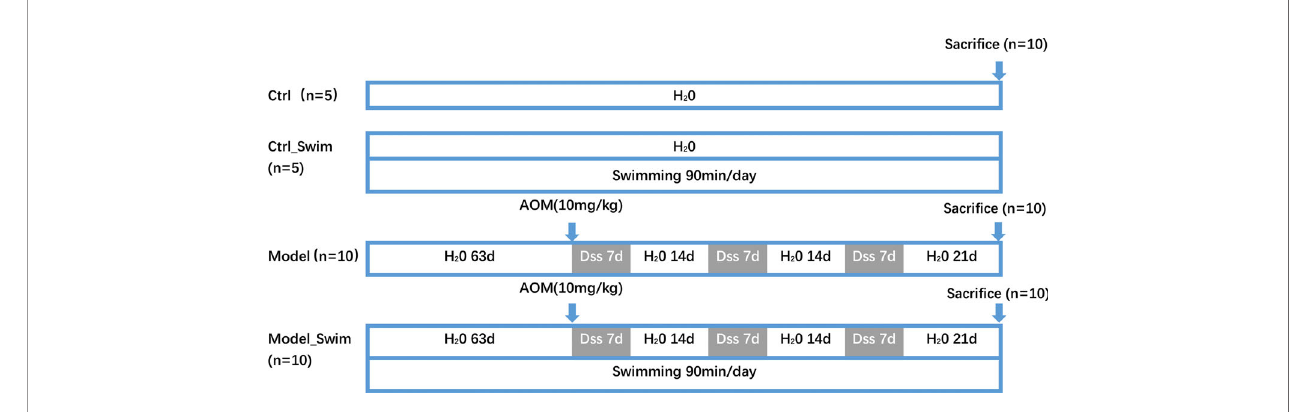
FIGURE 1 | Experimental schedule for AOM/DSS-induced CAC models in mice with swimming pretreatment. Ctrl, control;